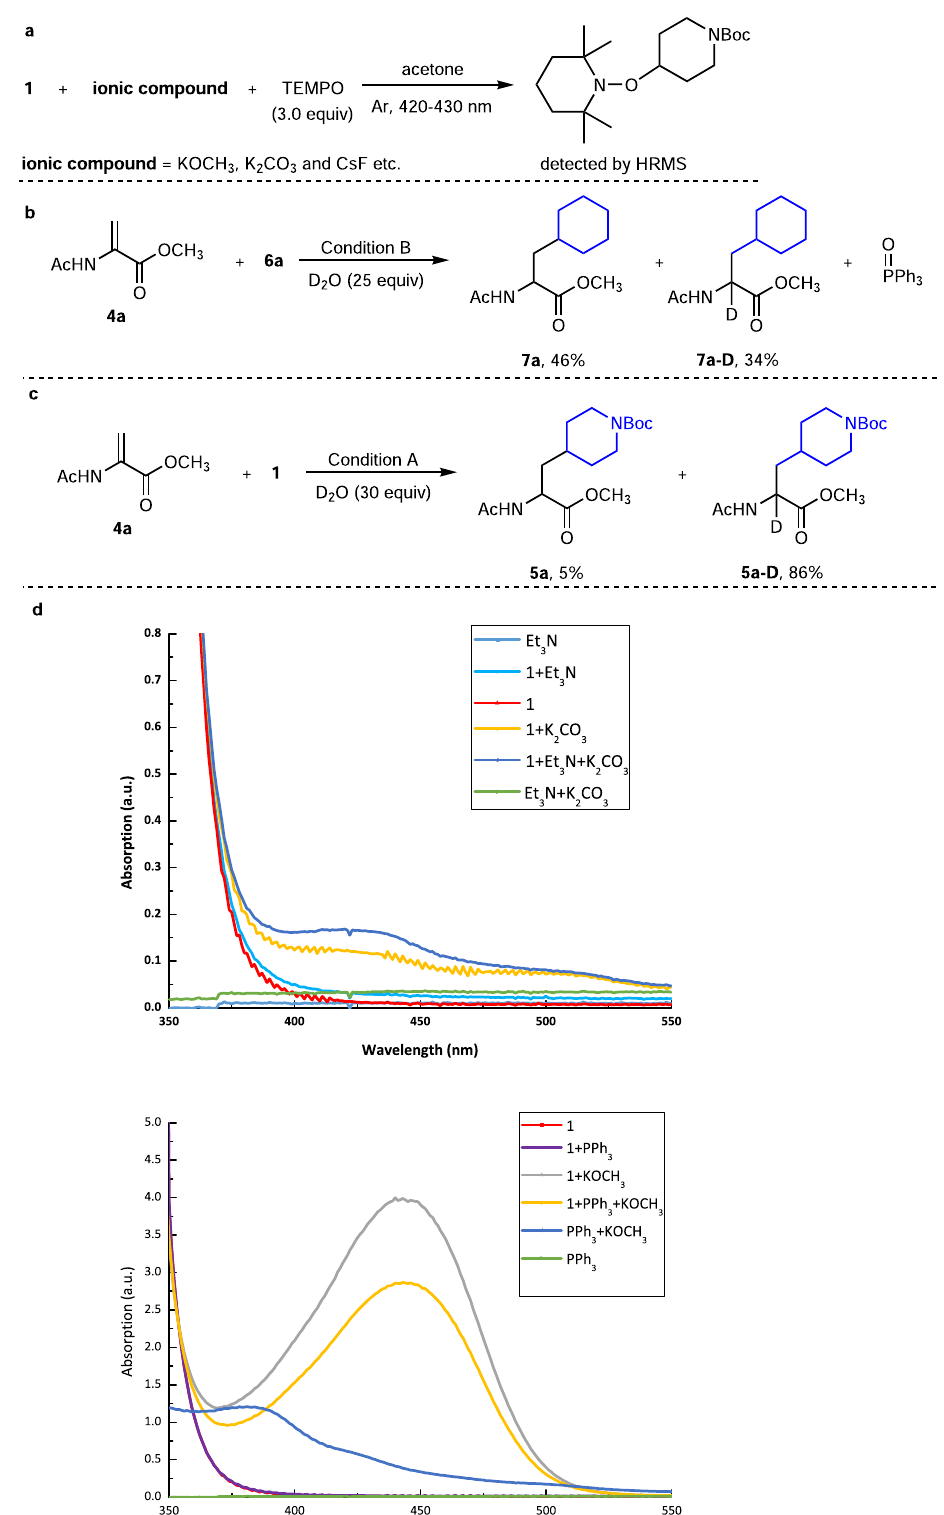
Fig. 4 Mechanistic studies. a Radical trapping experiments. b Isotope tracking experiments of Condition B. c Isotope tracking experiments of Condition A. d Analysis of UV-Vis absorption